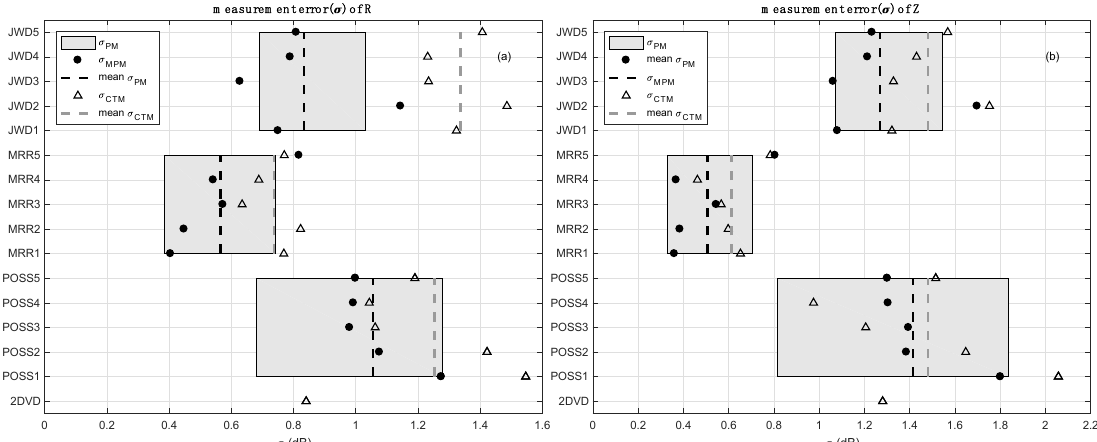
Figure 10. ( a ) Measurement noise of rainfall rate for each disdrometer. The boxes represent the range of the values of the σ (cid:2900)(cid:2897) for rainfall rate. The black dots represent the σ (cid:2897)(cid:2900)(cid:2897) for rainfall rate. The triangles represent the σ (cid:2887)(cid:2904)(cid:2897) . The dark dash lines represent the mean value of σ (cid:2900)(cid:2897) . The gray dash lines represent the mean value of σ (cid:2897)(cid:2900)(cid:2897) . ( b ) Same as in ( a ) but for reflectivity.